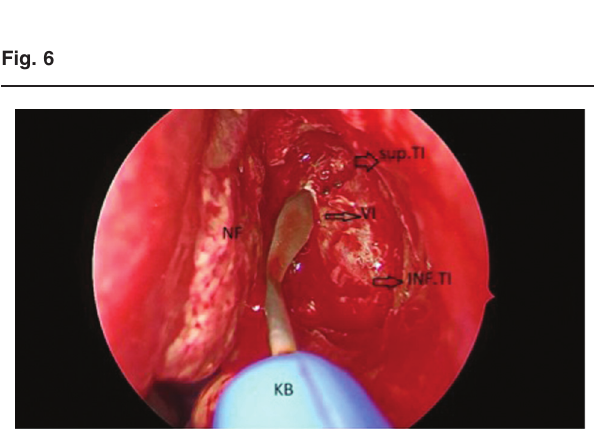
Lacrimal sac fully opened with anterior and posterior lacrimal flap formation, and both flap reflecting anteriorly and posteriorly respec- tively. (NF): nasal flap, (LB): lacrimal bone, (CLCO): common cana- licular opining, (ALF): anterior lacrimal flap , (PLF): posterior lacrimal flap.